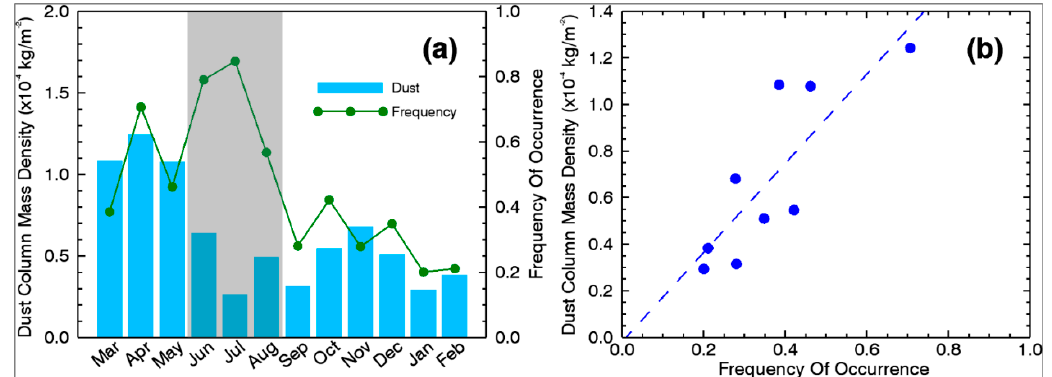
Figure 2. ( a ) Monthly occurrence frequency of cirrus clouds (green curve) measured by lidar at Wuhan, and monthly mean dust column mass density from MERRA-2 Model (blue bars). ( b ) Scatterplots showing their relationship except for the data in the summer months. The occurrence frequency shows a seasonal cycle with the highest frequency in summer (marked by grey shadow) and the lowest in winter (December to February). A positive correlation between the cirrus occurrence frequency and dust column mass density is found for the data except in the summer months.